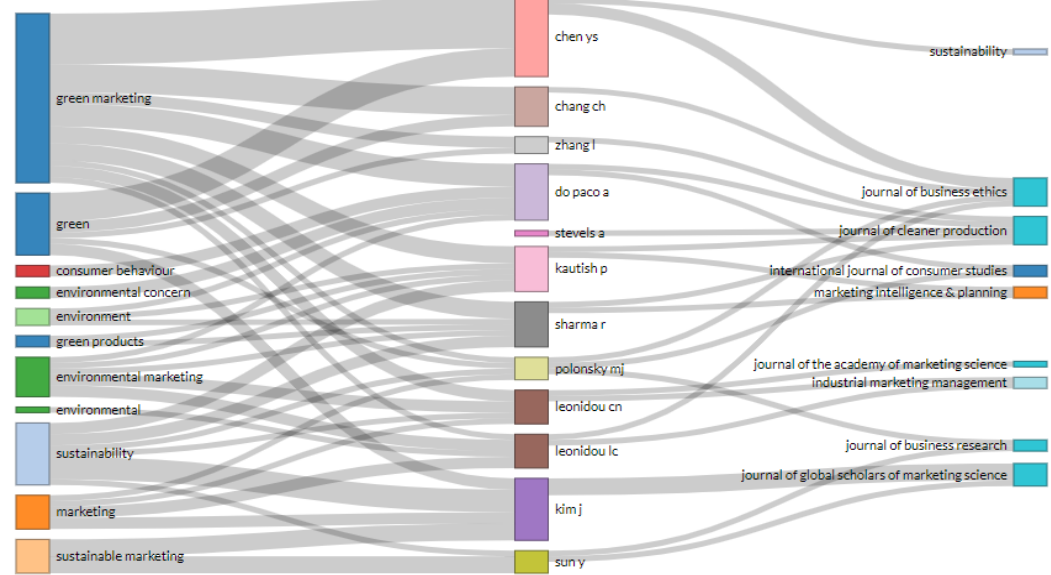
Figure 8. Three-factor analysis of the relationship among keywords ( left ), authors ( center ), and sources ( right ).